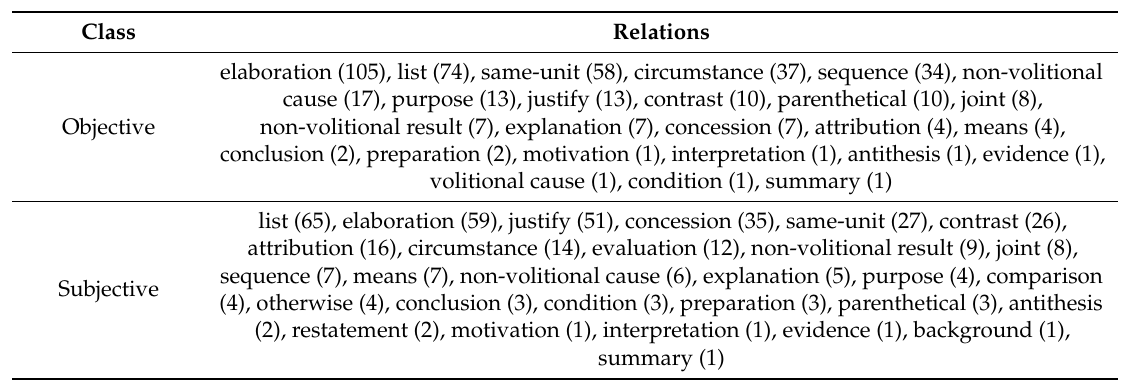
Table 4. Discourse relations present in the sentences per class, presented in decreasing order of the number of sentences in which they were found, with this information in